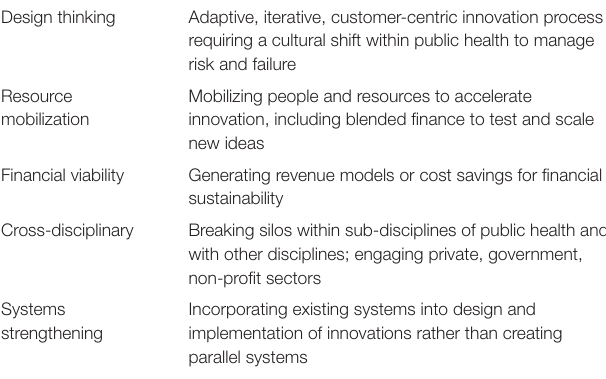
TABLE 3 | Components of the PHEI